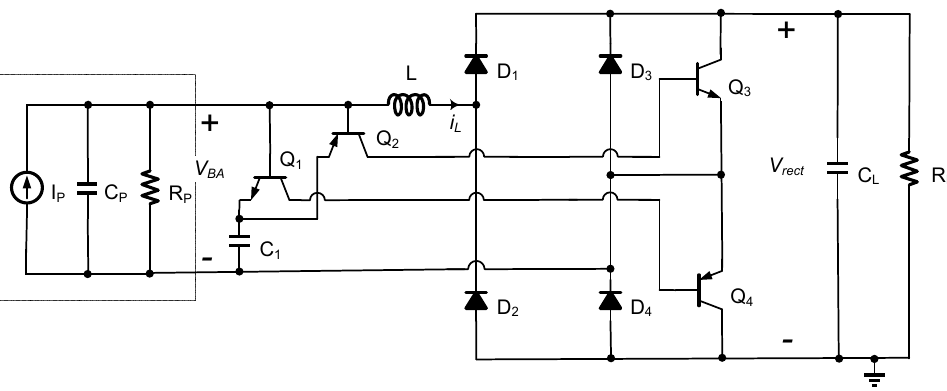
Figure 11. Proposed hybrid SSHI circuit integrated with a diode bridge rectifier. Before the PE transducer current i P crosses the zero point from positive to negative, the NPN transistor’s base-emitter of Q 1 is turned on to make the capacitors C 1 and C P connect in parallel. As the current i P crosses the zero point to discharge the capacitor C P , and the voltage V BA drops, since the voltage of the capacitor C 1 remains unchanged, the switch Q 1 is turned off and Q 2 is turned on. This results in Q 3 being turned on. It transfers the energy previously stored in the capacitor C P to the inductor L using the first resonant loop formed by internal capacitor C P and the inductor L, and so the inductor current i L increases. When the i L approaches its peak, the voltages across the inductor L and the capacitor C P are both approximately zero, forcing Q 3 to be turned off in the resonant loop. Once Q 3 is off, the second resonant loop is formed by the source, the inductor L, and the load. Its operation is already stated in Section 3.2. The rectified voltage could be higher than the PE voltage without being clamped due to the use of the second resonant loop.